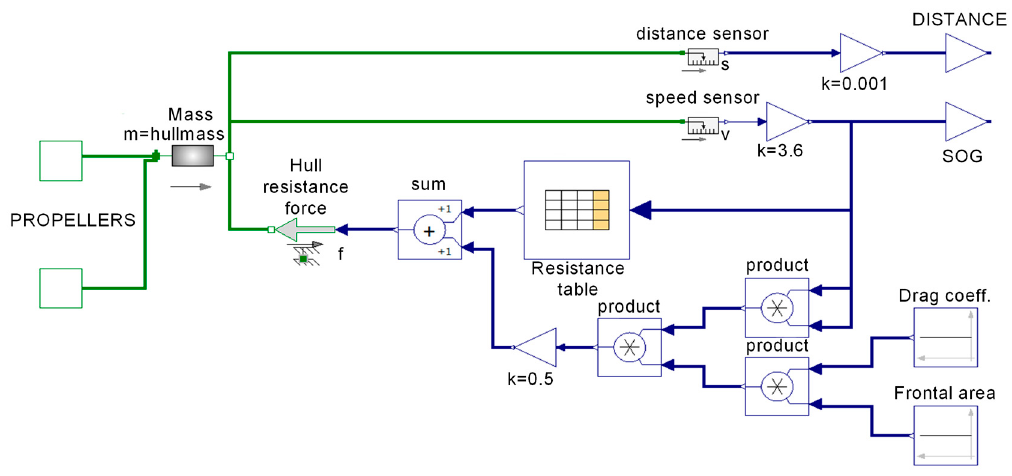
Figure 18. Model of the ship’s hull and hull resistance components developed in Modelica. The mass block is directly related to the R TOT hull resistance force block, the value of which is the sum of the hydrodynamic and aerodynamic resistances (1). The value of the total aerodynamic drag R air is derived from the drag equation: